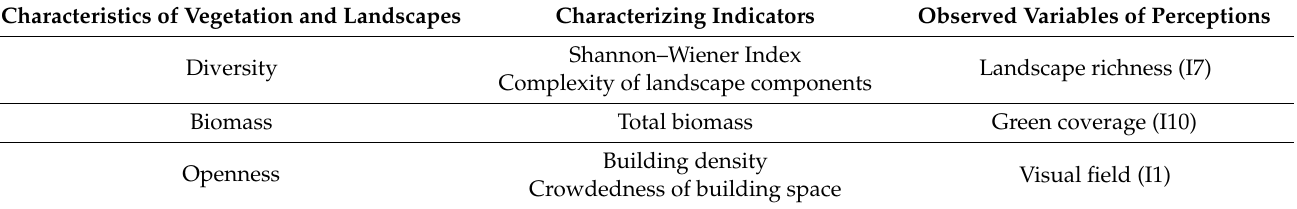
Table 3. Vegetation and landscape characteristics, their characterizing indicators, and their corre- sponding observed